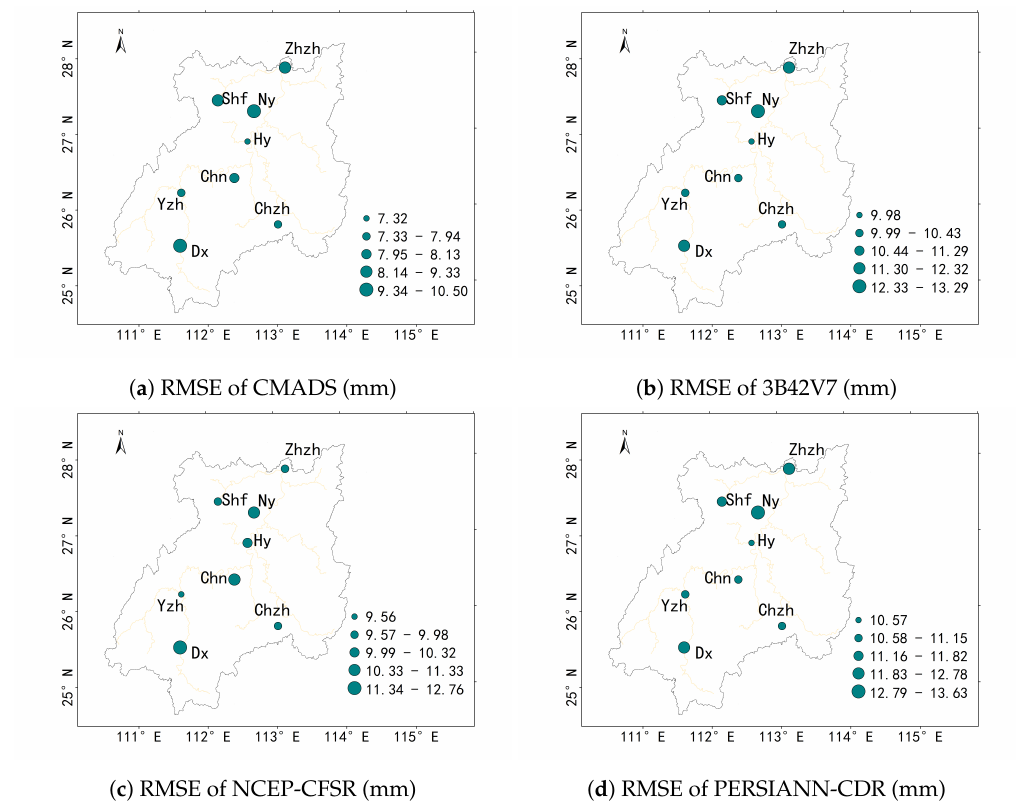
Figure 5. Spatial distribution of the RMSE of daily precipitation